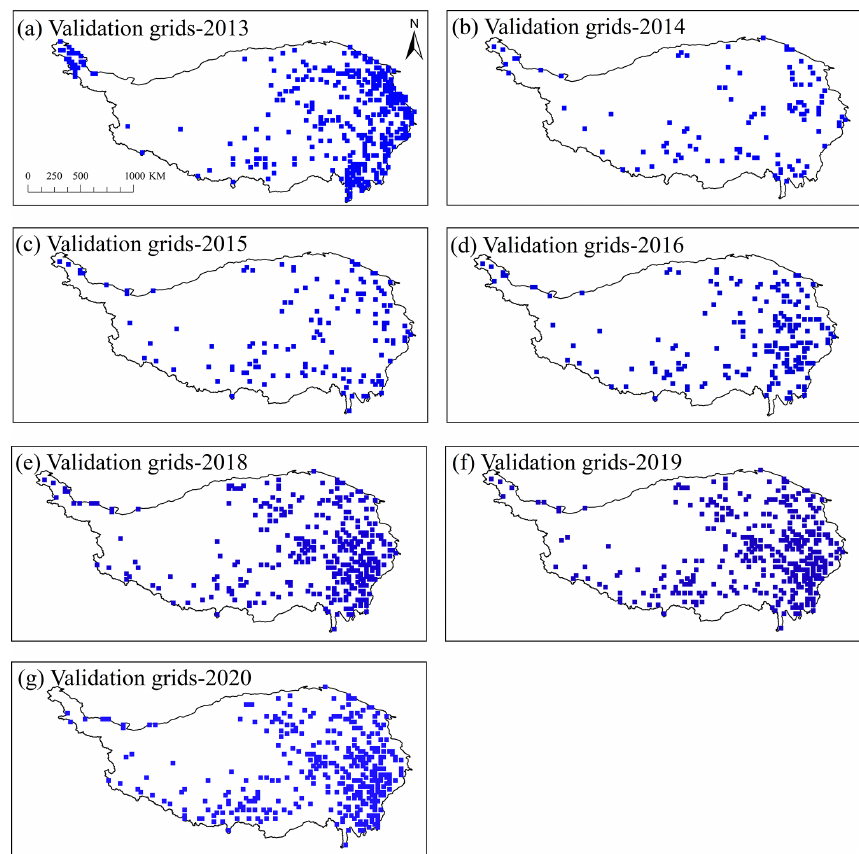
Figure 3. Spatial distribution of validation grids covering the TP for 2013–2020 (excluding